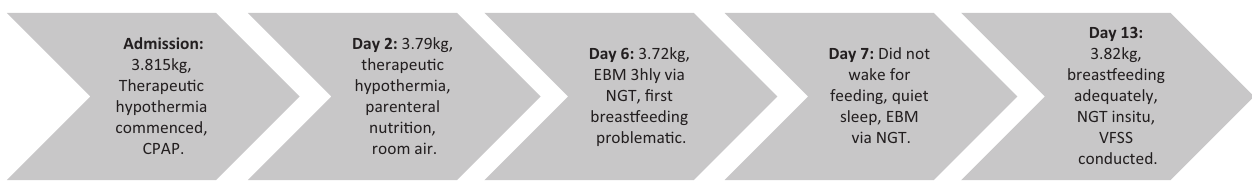
FIGURE 1: Chronological events from admission to